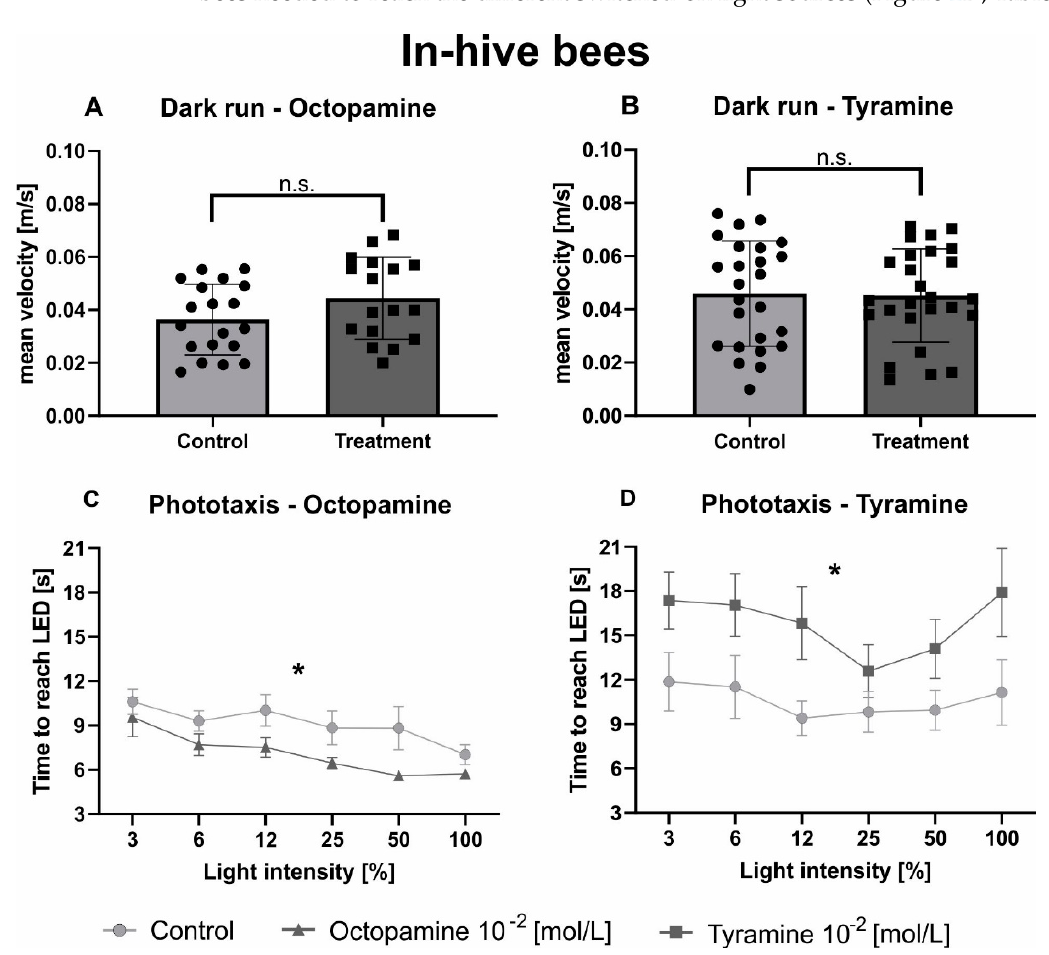
Figure 2. Octopamine and tyramine have opposite effects on the phototaxis of in-hive bees. Control bees are shown in light grey. Those injected with OA (10 − 2 mol/L) or TA (10 − 2 mol/L) are shown in dark grey. ( A , B ): Average velocity (mean + standard deviation) of honeybees during one minute of constant movement in the dark arena. Neither OA nor TA differed significantly from the Ringer control in their mean velocity in the dark (Table 3). ( C , D ): Average walking time (mean + standard error) towards the different switched-on light sources. The factor light intensity significantly influenced phototactic behaviour (Table 3). Octopamine decreased the time honeybees needed to reach the switched-on LEDs significantly compared to the control solution, while TA increased it (Table 3). Significant differences between Ringer and OA/TA are indicated by asterisks (n.s. p > 0.05, * p < 0.05).